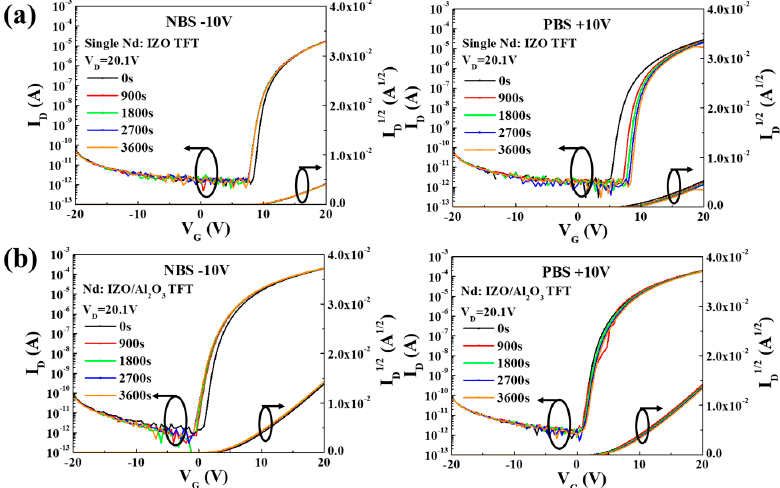
Figure 3. The electrical stabilities of ( a ) a single Nd:IZO TFT and ( b ) a Nd:IZO/Al 2 O 3 TFT under NBS (V G = − 10 V) and PBS (V G = +10 V) for 1 h.